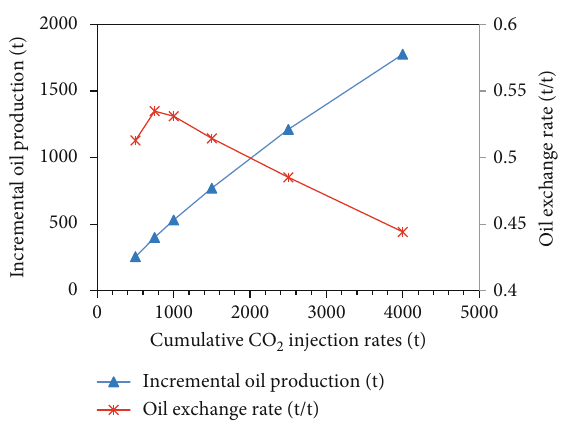
Figure 15: Incremental oil production and oil exchange rate through CO hu ff -n-pu ff under di ff erent total CO 2 volumes.